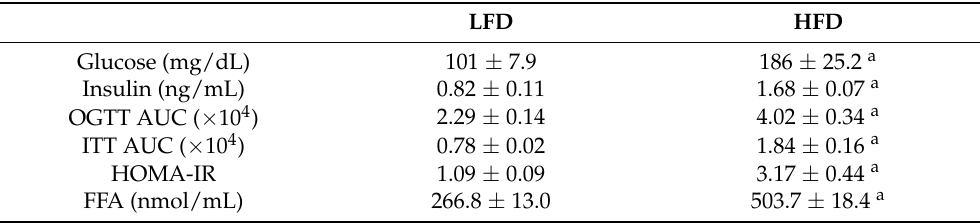
Table 1. Glycemic parameters and free fatty acids concentration (FFA) in the plasma of LFD and HFD animals. Values are mean ± SD ( n = 6 per group); a — p < 0.05 vs. LFD; significance by t